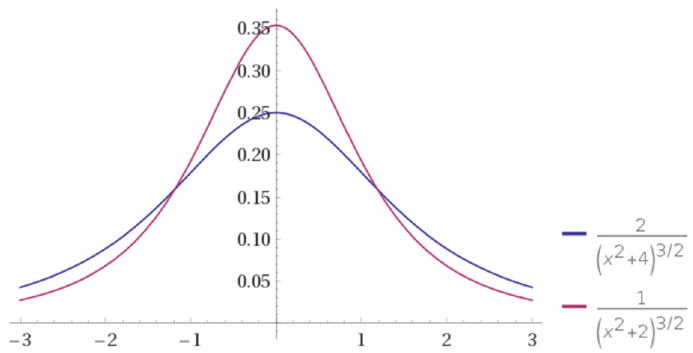
Figure 4. The Koenker distribution as a scaled version of Student’s t distribution, ν = 2.